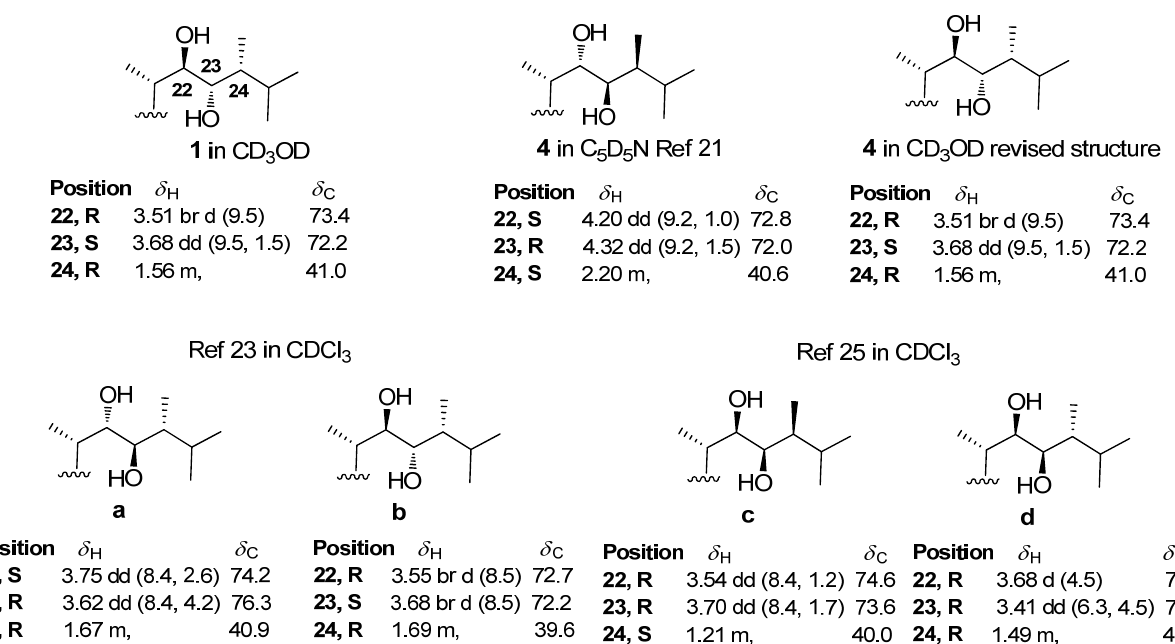
Figure 2. Comparison of NMR data of the aglycon